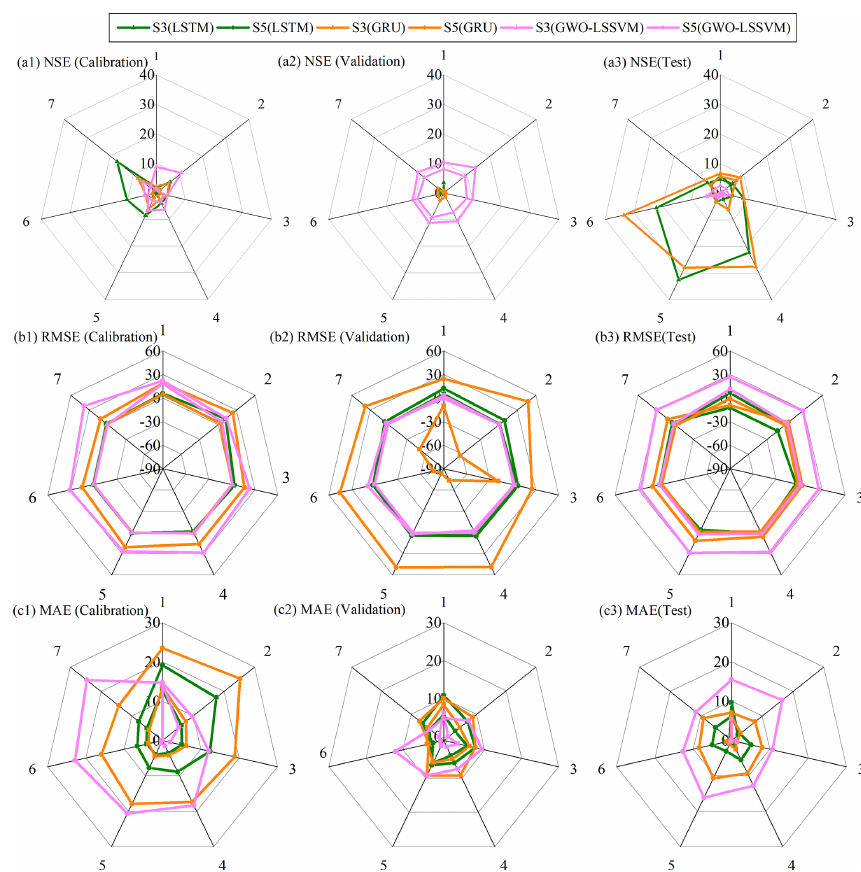
Figure 9. Improvement rates in terms of averaged (a) NSE, (b) RMSE, and (c) MAE of the BMA model for forecasts as compared with the three individual